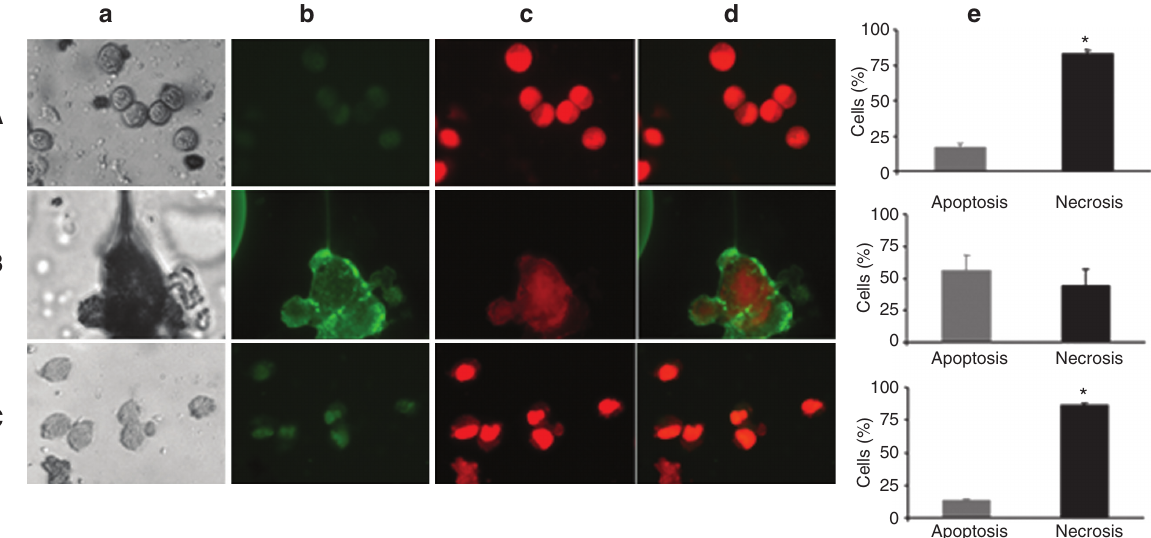
Figure 6 AO-EB dual staining of (A) LNCaP cells and (B, C) GT1-7 neurons pretreated with SPIONs@Au-LHRH for 24 h and then exposed to a magnetic field strength of 465 Oe: (A, B) applied at a frequency of 44 Hz for 1x15 min and (C) applied at a frequency of 44 Hz for 2 × 15 min. The concentrations of SPIONs@Au-LHRH employed in the case of LNCaP cells and GT1-7 neurons were 100 and 250 μ g/ml, respectively. Within A–C, representative images of (a) phase contrast microscopy and cells stained with (b) AO and (c) EB are presented along with (d) combined images of b and c (magnification: 400 × ). The corresponding % apoptotic and necrotic cells in LNCaP cells and GT1-7 neurons are shown in